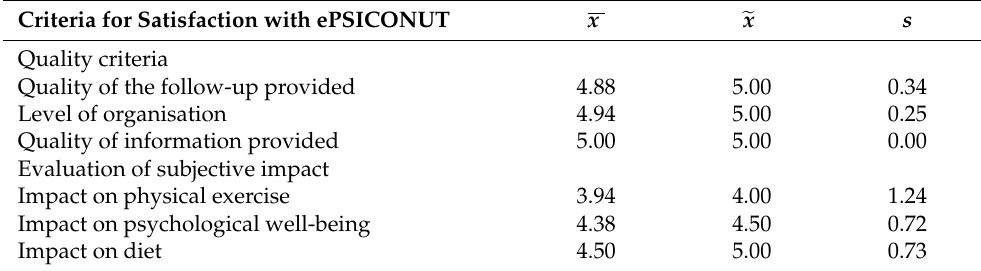
Table 8. Quantitative results of the ePSICONUT Programme Satisfaction Survey. Criteria for Satisfaction with